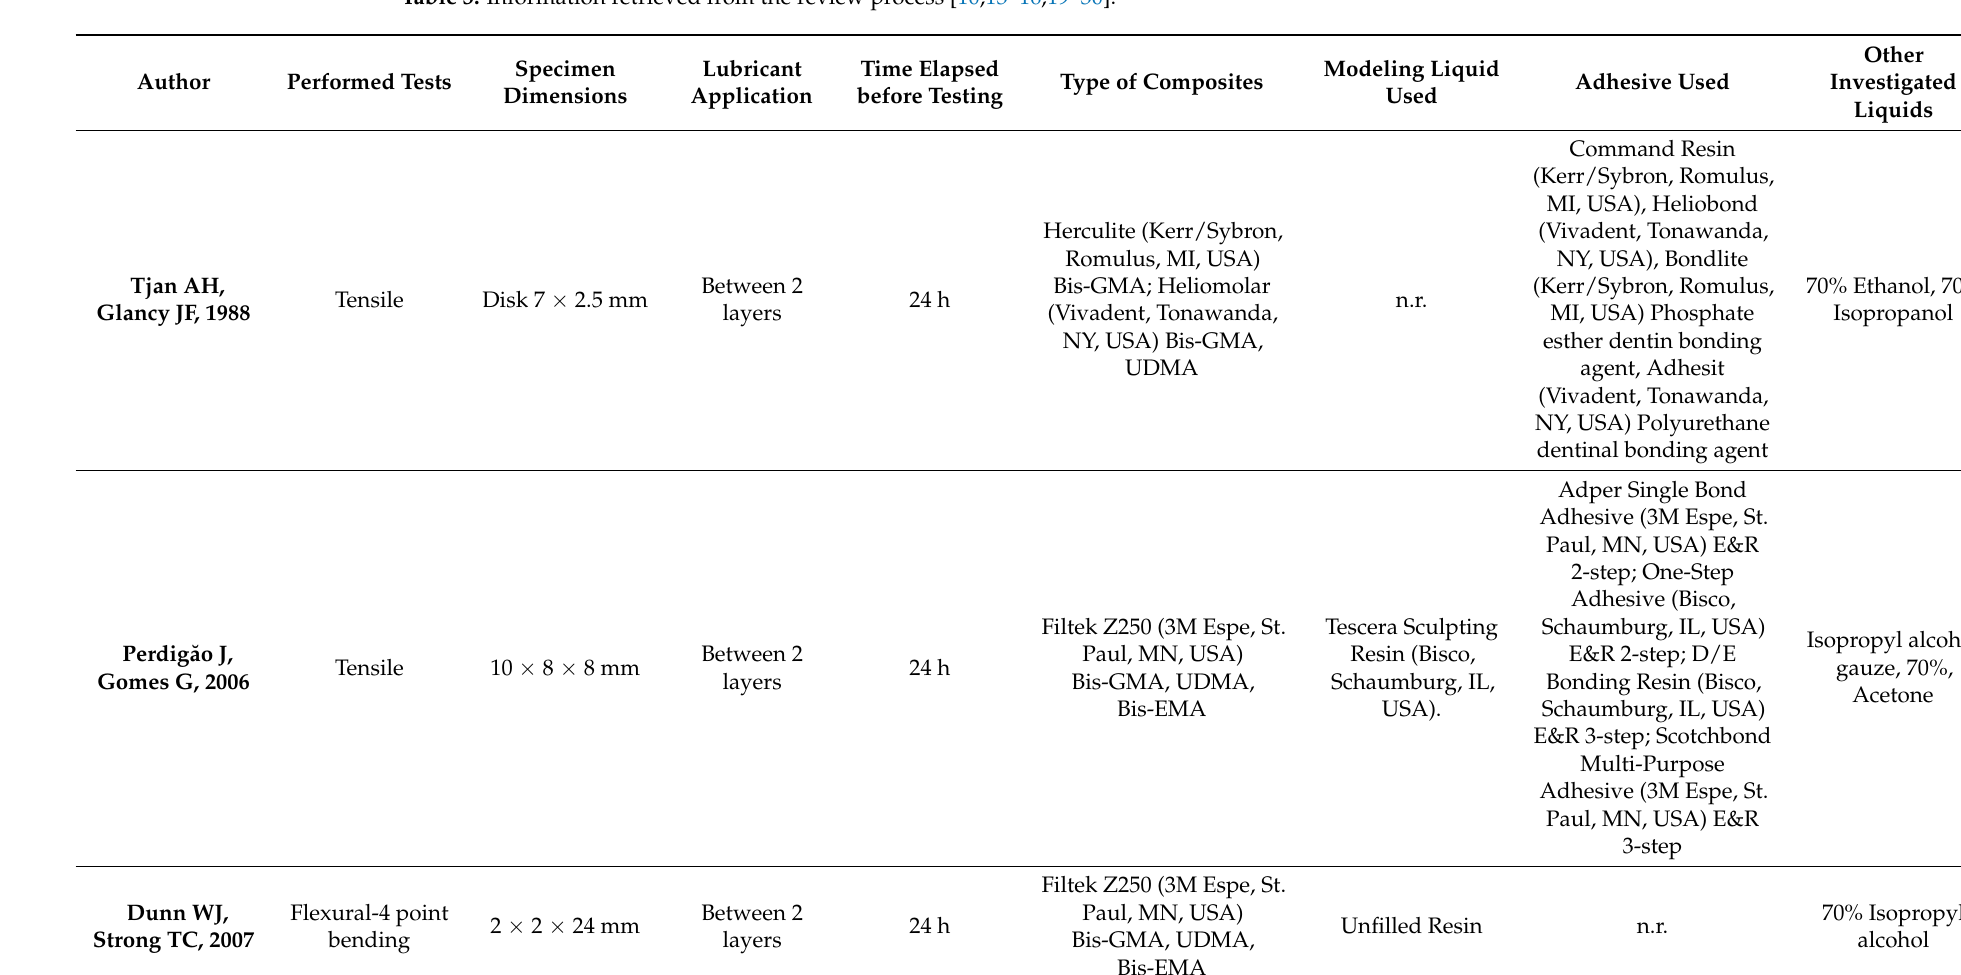
Table 3. Information retrieved from the review process